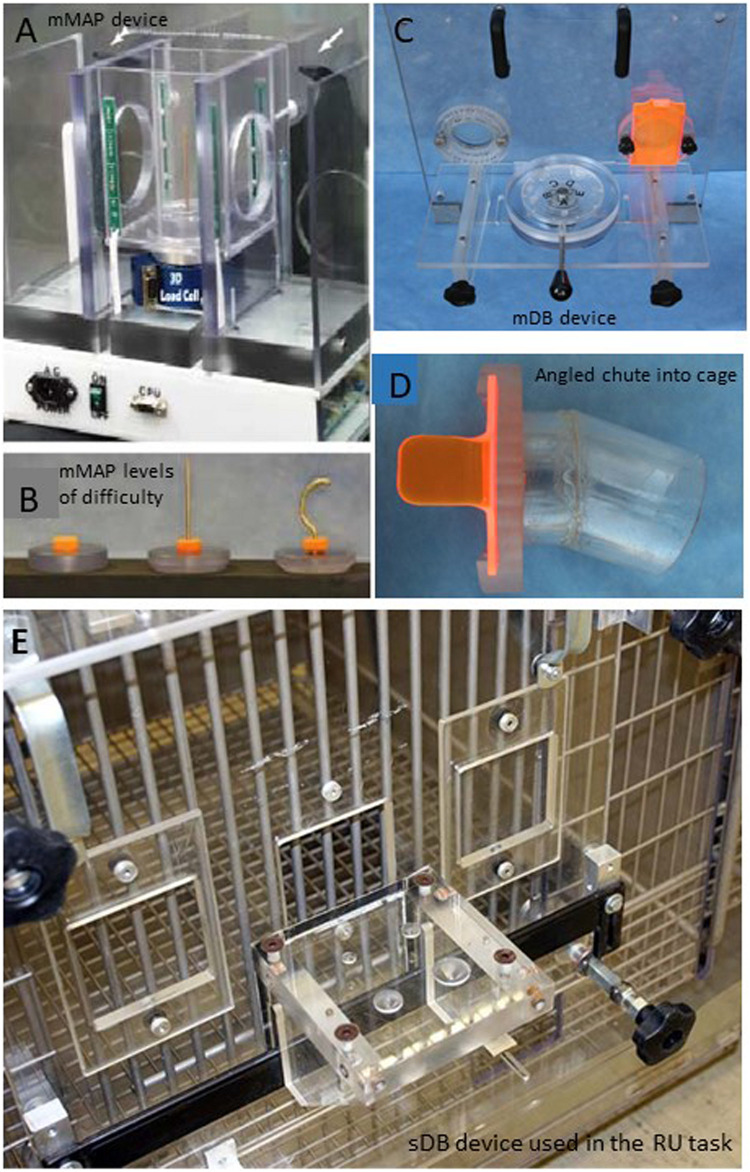
Pictures of the devices used to measure upper limb motor function. The modified movement assessment panel is shown in panel (A) with the different levels of difficulty shown below in panel (B). The modified dexterity board is shown in panel (C) with the angled chute into the cage that the monkey has to move the hand through to reach to the food target. The angled chute constrains which hand can be used to successfully reach to the food target (D). The standard dexterity board used in the pre-lesion handedness test and the post-lesion reduced use tests when the animals can choose which hand to use is shown in panel (E).